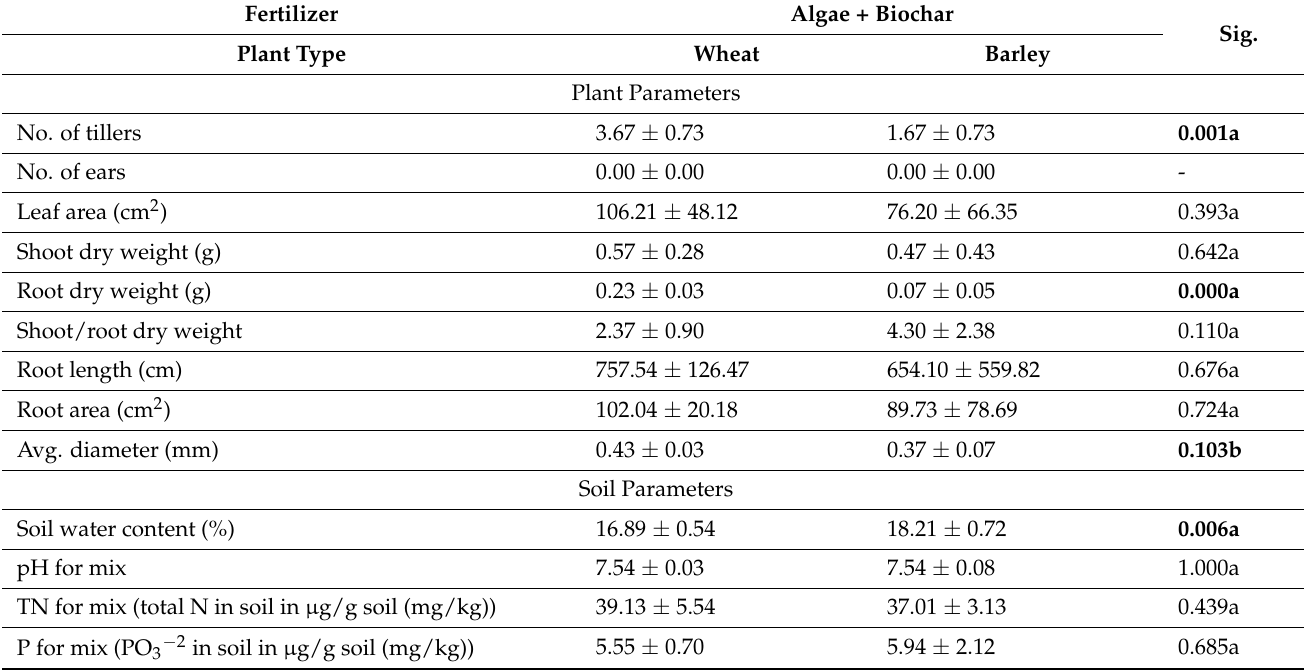
Table 4. The synergic effect of biochar and dried algae biomass on early growth stage (7 weeks) of wheat and